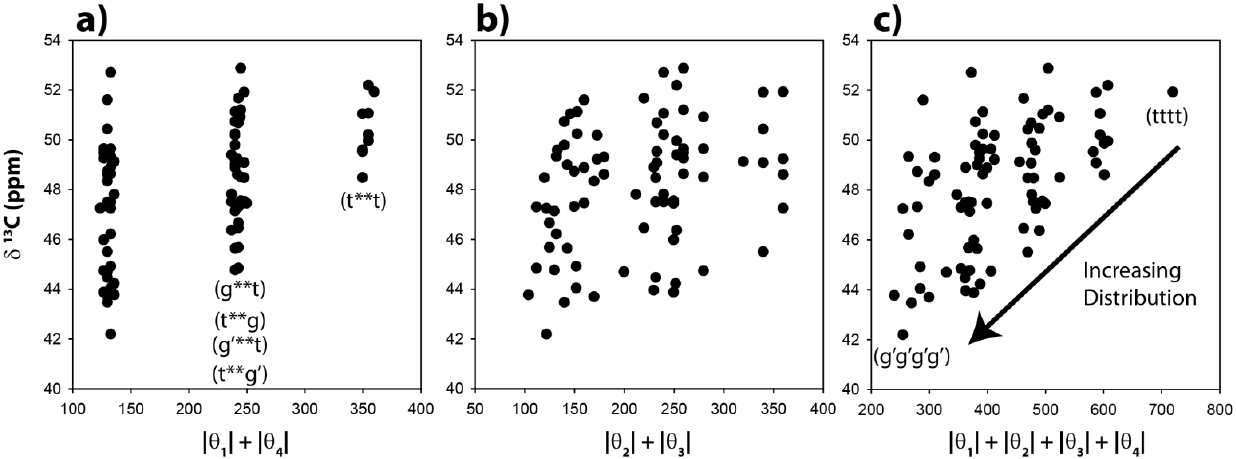
+ | θ | dihedral angle summation, ( b ) the | θ | 1 4 + | θ | + | θ | + | θ | dihedral angle 1 2 3 4